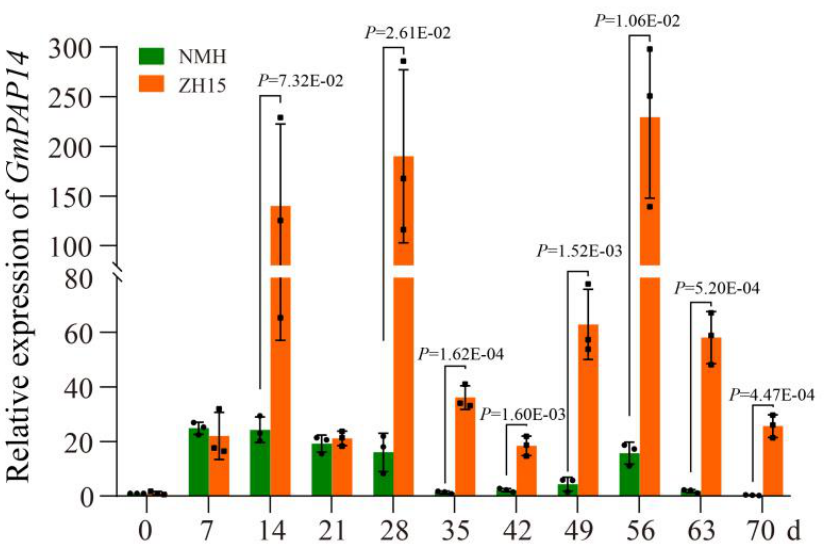
Figure 1. Analysis of GmPAP14 expression in roots of zhonghuang (ZH15, P efficient soybean) and niumaohuang (NMH, P inefficient soybean). Seven-day-old seedlings were treated with normal P (NP, 1 mmol/L KH 2 PO 4 ) and low P (LP, 1 mmol/L phytate). Seedlings treated with NP were used as a control. The roots were sampled after 7, 14, 21, 28, 35, 42, 49, 56, 63 and 70 days and were used for temporal expression analysis. The relative expression was calculated using the 2 − ∆∆ Ct method, and all data represent the means ± SD, n = 3. Error bars represent the SD. A t -test was used to identify the differences between the data.